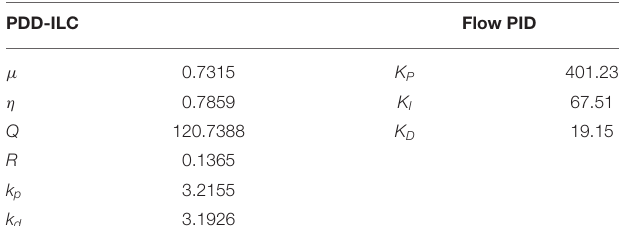
TABLE 1 | Optimized control parameters for PDD-ILC and flow PID controllers. PDD-ILC